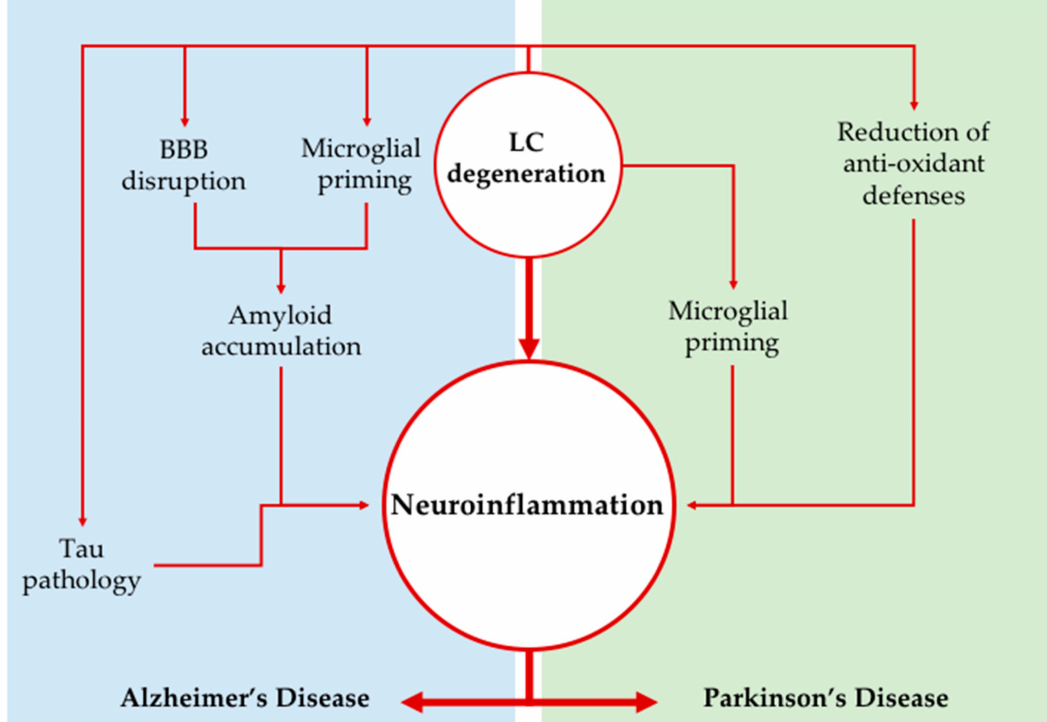
Figure 1. Locus Coeruleus degeneration as a driver of neuroinflammation. The impairment of the LC-NA system may promote neuroinflammation in neurodegenerative disorders through several mechanisms; the loss of NA modulation causes microglial cells to change their phenotypes into a more reactive one. Moreover, in Alzheimer’s disease, NA impairment concurs to BBB breakdown and amyloid and phospho-tau accumulation (Tau pathology), which together further exacerbate neuroinflammatory phenomena. On the other hand, in Parkinson’s disease, increased oxidative damage related to inflammation has been observed after LC lesion. BBB: blood brain barrier; LC: Locus Coeruleus; NA: